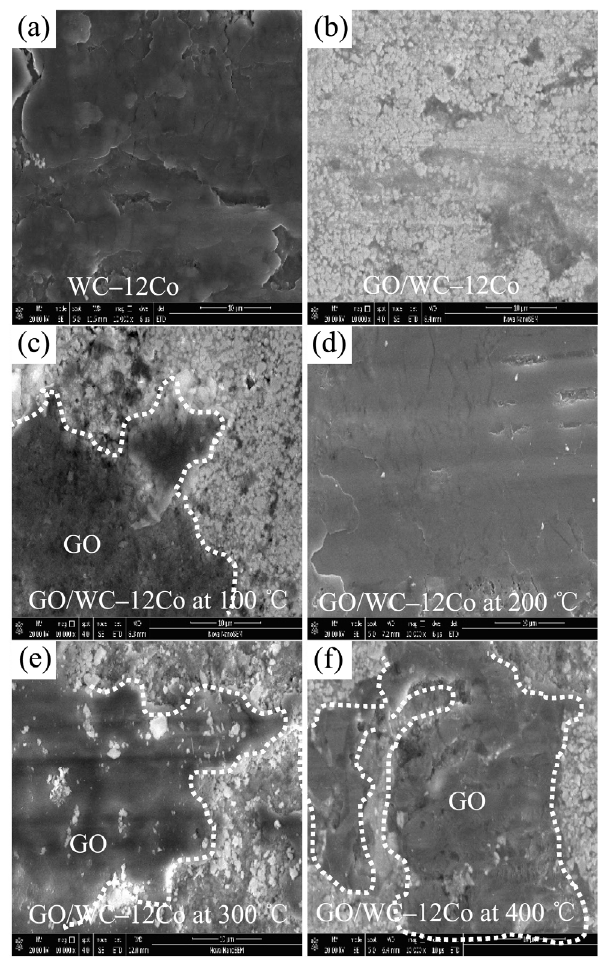
Fig. 14 Micromorphologies of the wear tracks in the coatings after undergoing high-temperature